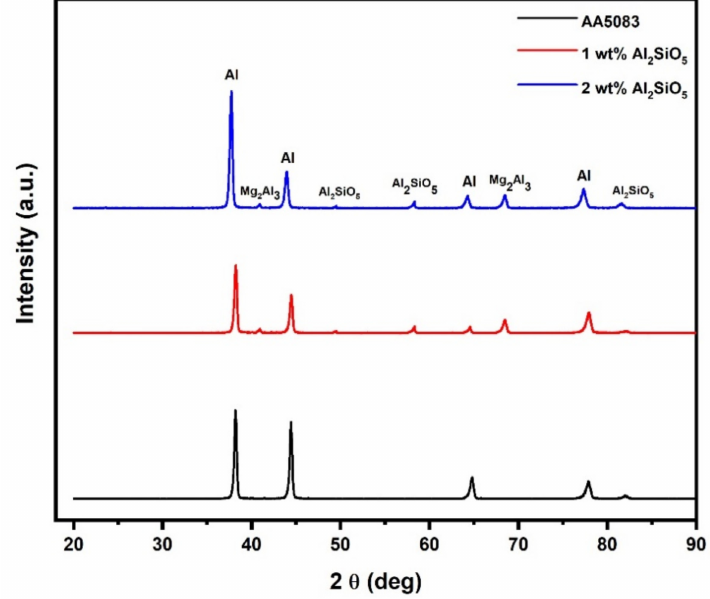
Figure 6. XRD analysis of AA5083- and Al 2 SiO 5 -reinforced material after shock wave treatment.